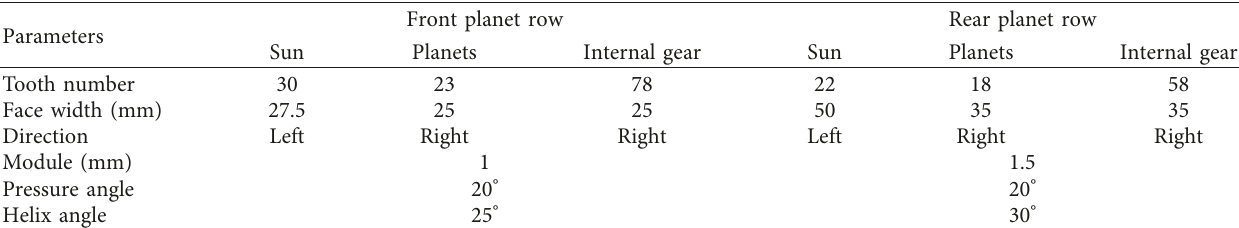
Figure 1: Assembly model of the power coupling Table 1: Gear parameters of the front and rear planet rows.